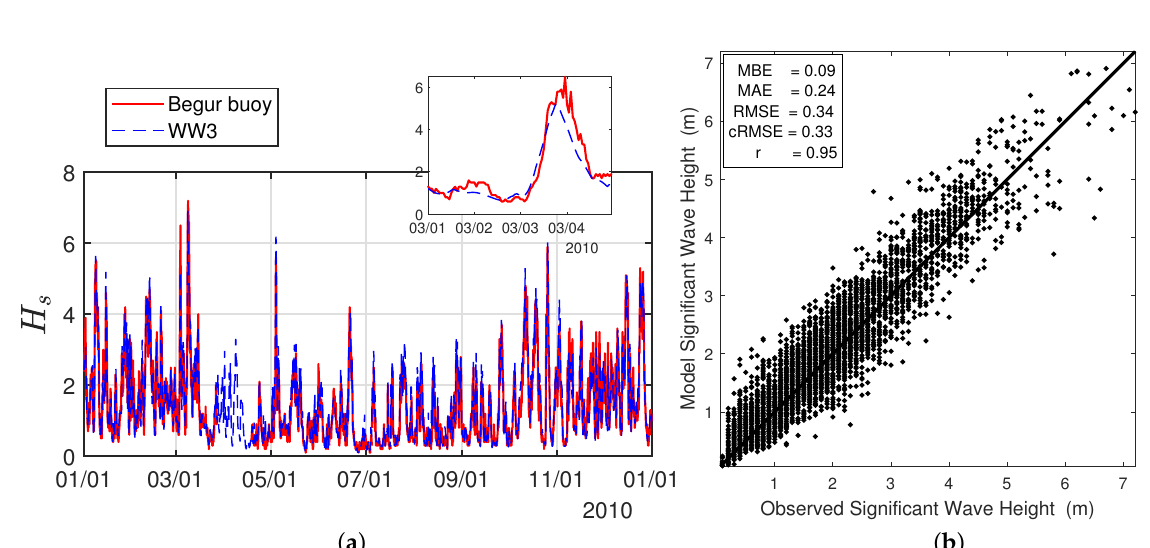
Figure 2. Time series of the significant wave height during year 2010 from the present WWIII hindcast and from Begur buoy ( a ), with the inset showing the period from 1 March 2010 to 4 March 2010; on the right panel; ( b ) scatter plot representation of the significant wave height, with mean bias error (MBE), mean absolute error (MAE), root mean-square error (RMSE), centered root mean-square error (cRMSE), and correlation coefficient